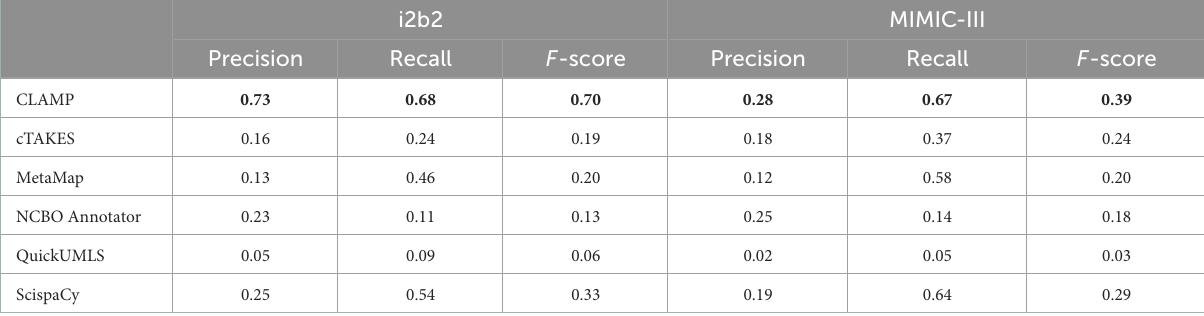
TABLE 3 Clinical concept recognition system performance on exact match at extracting clinical concepts from the i2b2 and MIMIC-III datasets. i2b2